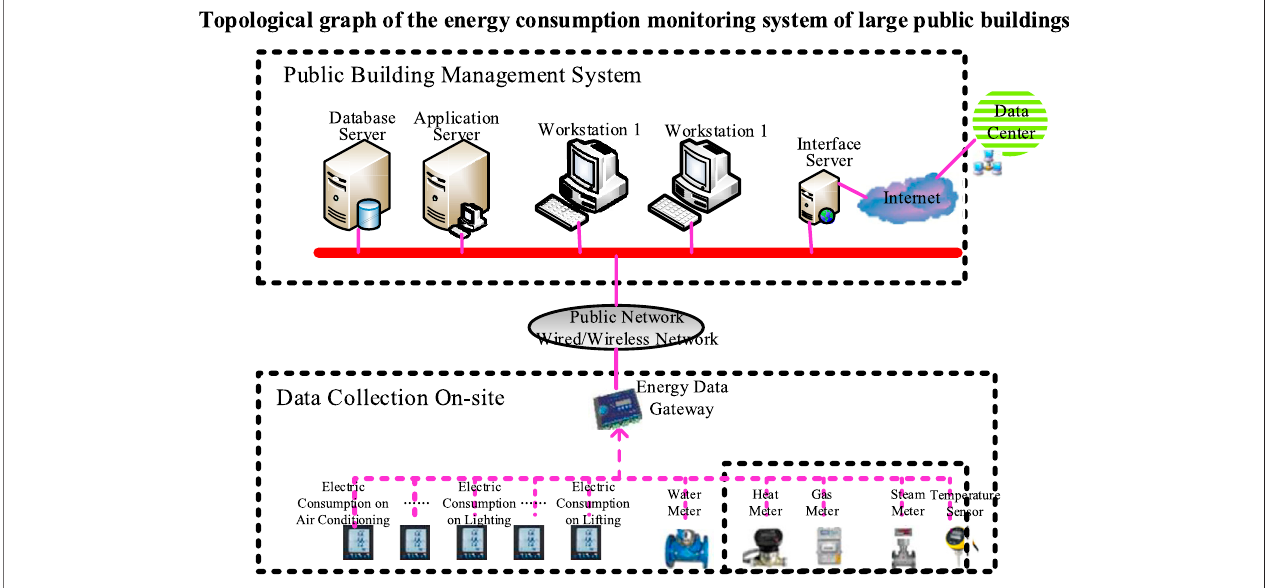
FIGURE 11 | Topological graph of the energy-consumption monitoring system. Source: Energy-consumption monitoring platform of Xi ’ an